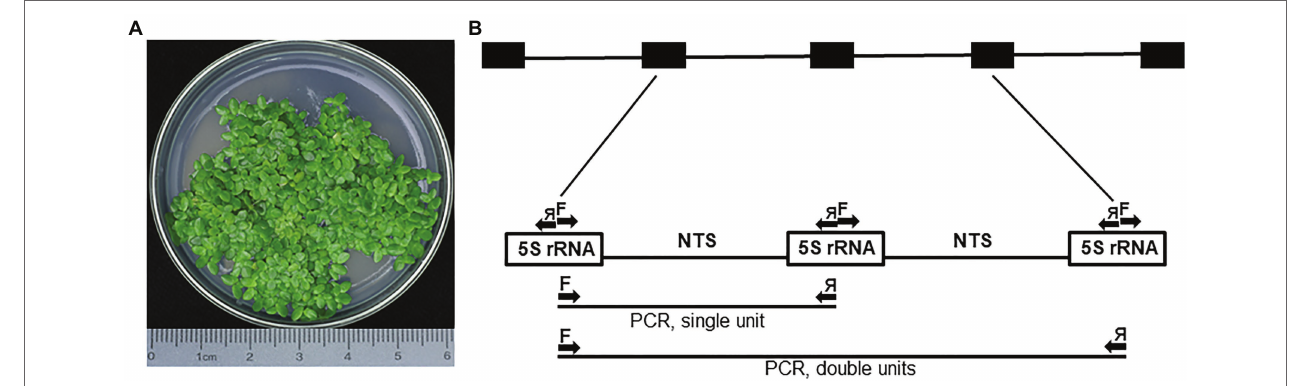
FIGURE 1 | The PCR amplification of 5S rDNA units in Landoltia punctata NB0014. (A) Representative image of the Landoltia punctata ecotype NB0014 during in vitro culture; the species identity was confirmed by the chloroplast DNA barcoding. (B) Schematic representation of the complete 5S rDNA locus and the PCR amplification scheme. Arrows represent forward (F) and reverse ( я ) primers used during PCR and may amplify single or double 5S rRNA units. The array of black boxes at the top represents the 5S rDNA locus, and the white boxes represent the DNA sequences transcribed to produce the 5S rRNA. NTS, nontranscribed spacer.